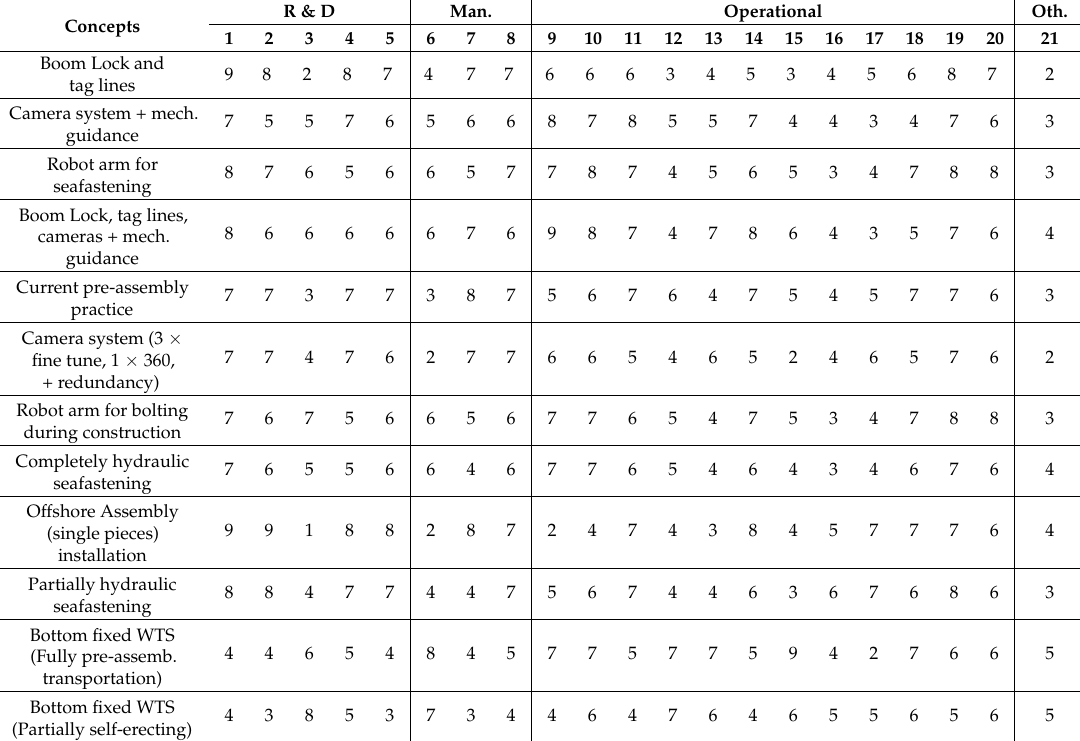
Table 6. Second stage Decision Matrix, averaged values. (Category numbers 1–21 as in Figure 6). R & D Man. Operational Oth. Concepts